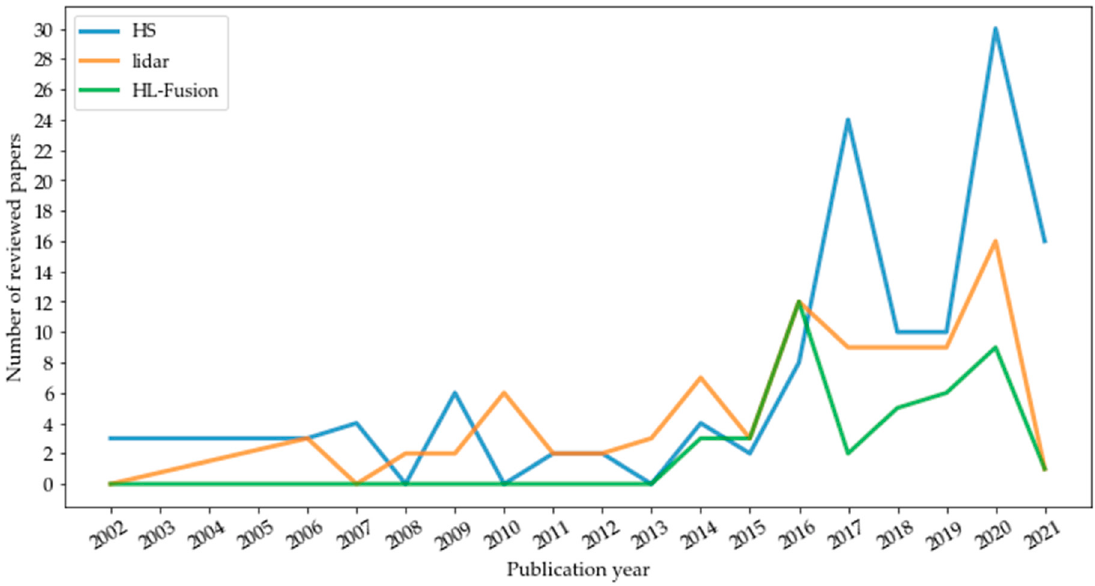
Figure 9. Each color is assigned to a different sensor, such as HS, lidar, and